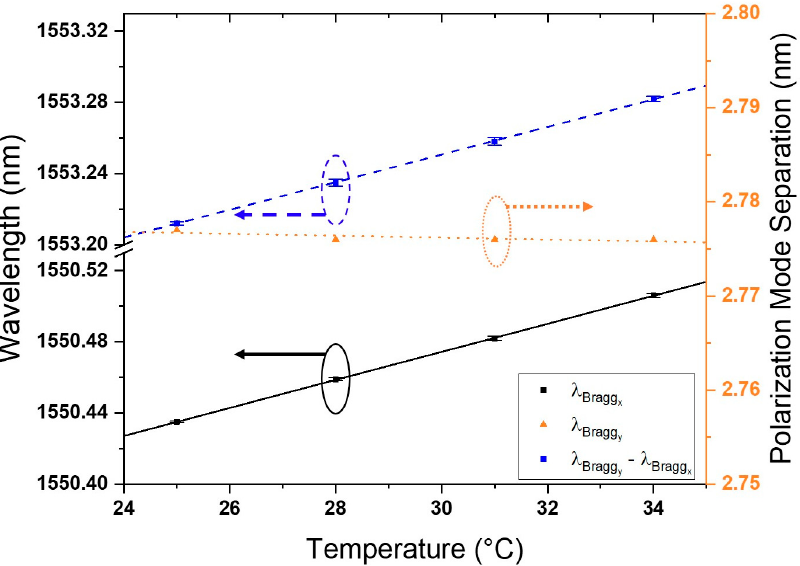
Figure 10. Sensor response to changes in ambient temperature.